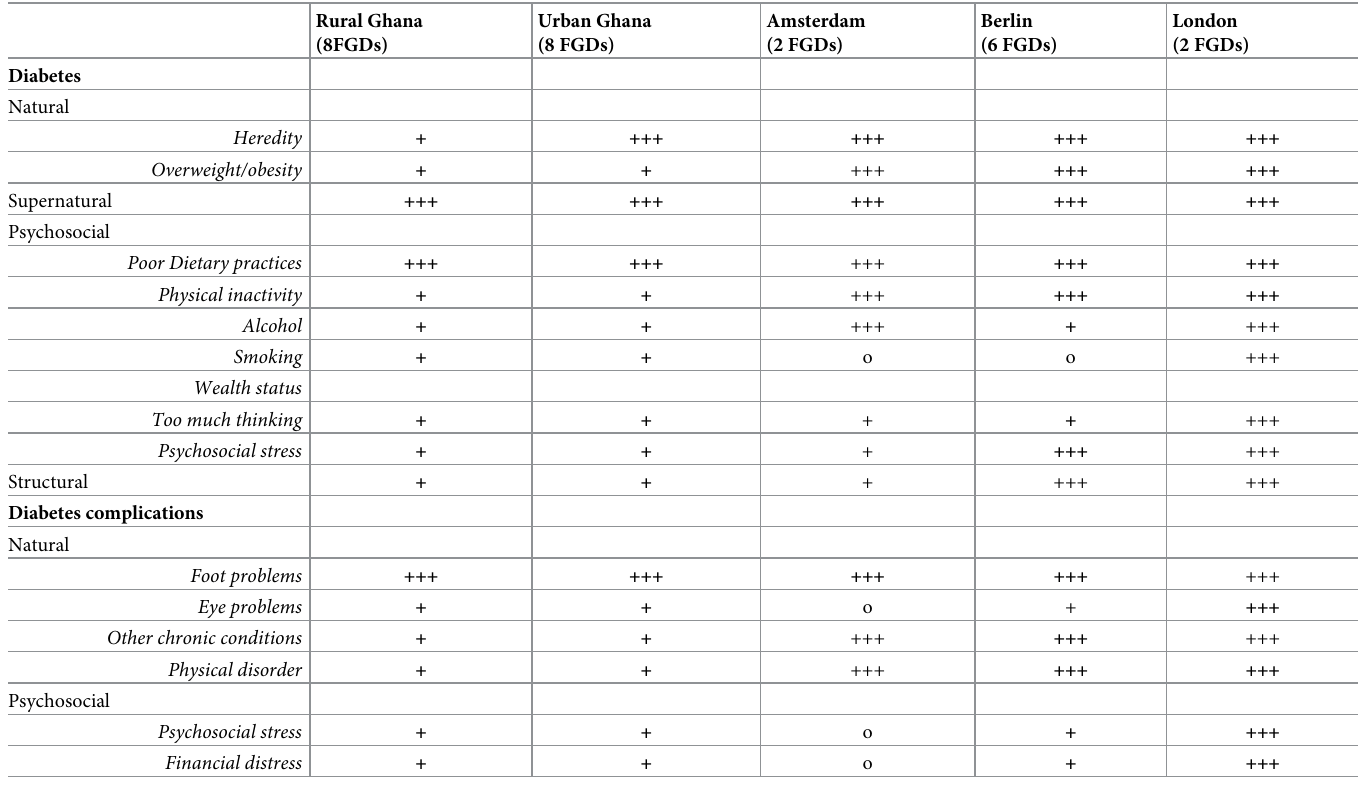
Table 2. Spread and dominance of theories of T2D and T2Dcomplications across the five study